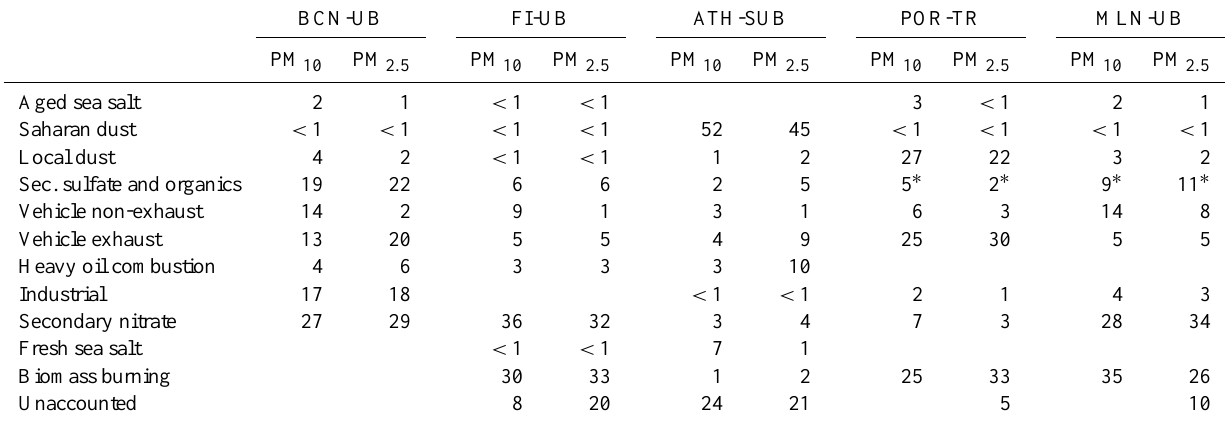
Table 3. Average contribution (%) of PM 10 and PM 2 . 5 sources during high pollution days (PM 10 > 50µgm − 3 and > 40µgm − 3 in BCN-